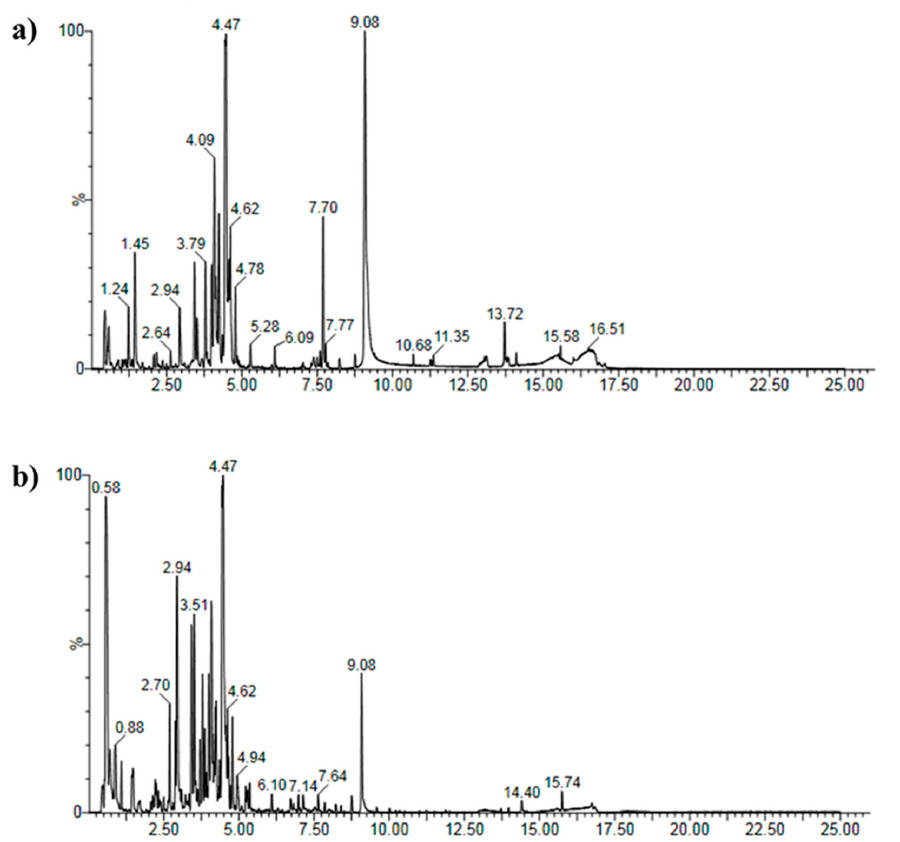
Figure 2. High-resolution extracted ion chromatograms for MA-DME: ( a ) positive ion mode; ( b ) negative ion mode.